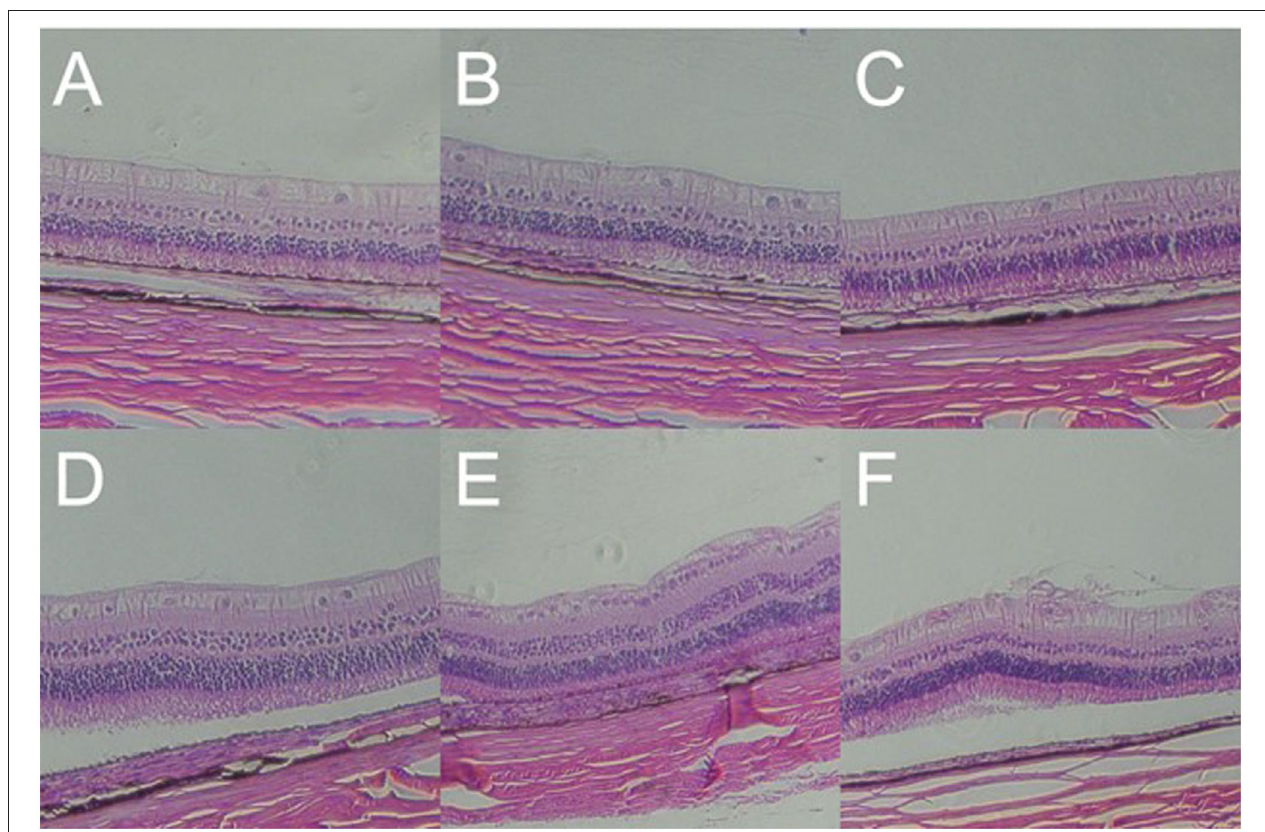
FIGURE 8 | Gross pathology of retinas of animal model with closed globe blast injury at day 7. (A) : Blank control group: 10 layers of the retina were integral and well-organized with normal thickness. Morphology of retinal cells were normal ( × 100). (B) 500 Kpa group: Retinal ganglion cells (RGCs) were arranged in order, and the nucleus were distributed evenly ( × 100). (C) 1,000 Kpa group: The retinal ganglion cells were arranged neatly, and the nucleus arrangement was tighter than control group ( × 100). (D) 1,500 Kpa group: The nucleus arrangement was tighter than 1,000 Kpa group ( × 100). (E) 2,000 Kpa group: The retinal ganglion cells were disordered, and the nucleus were dense ( × 100). (F) 5,000 Kpa group: RGCs nucleus were karyopyknotic, and like vesicular nucleus ( × 100).